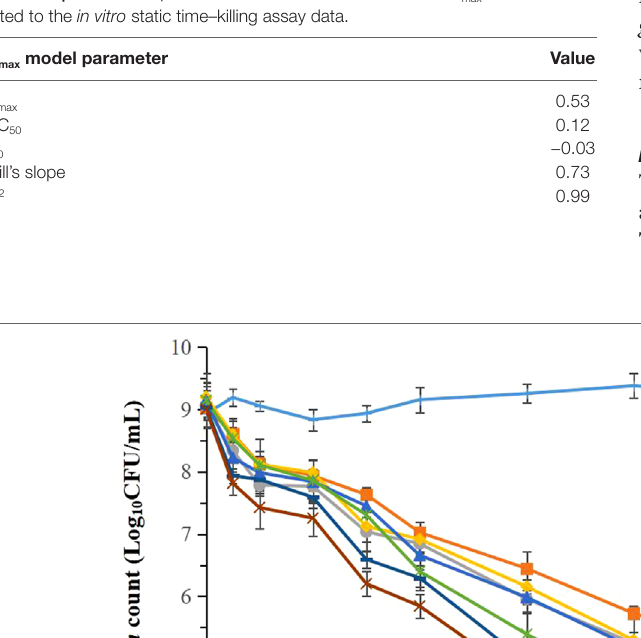
TABLE 1 | The kill rate parameter estimation derived from the E max model which fitted to the in vitro static time–killing assay data.